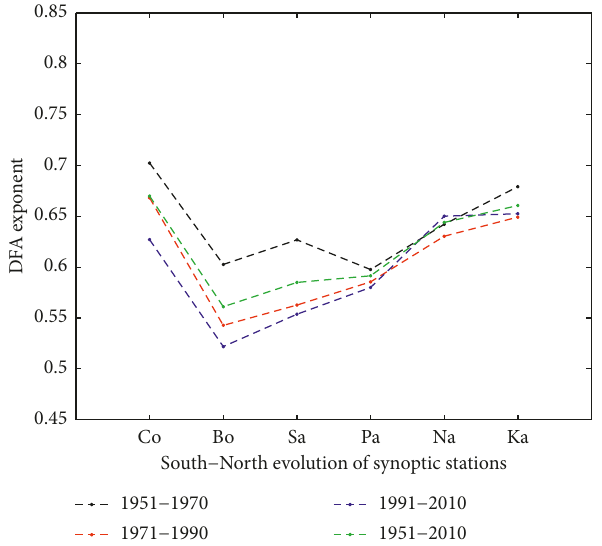
Figure 6: Spatiotemporal variation of DFA exponents ( ℎ ) obtained by the DFA2